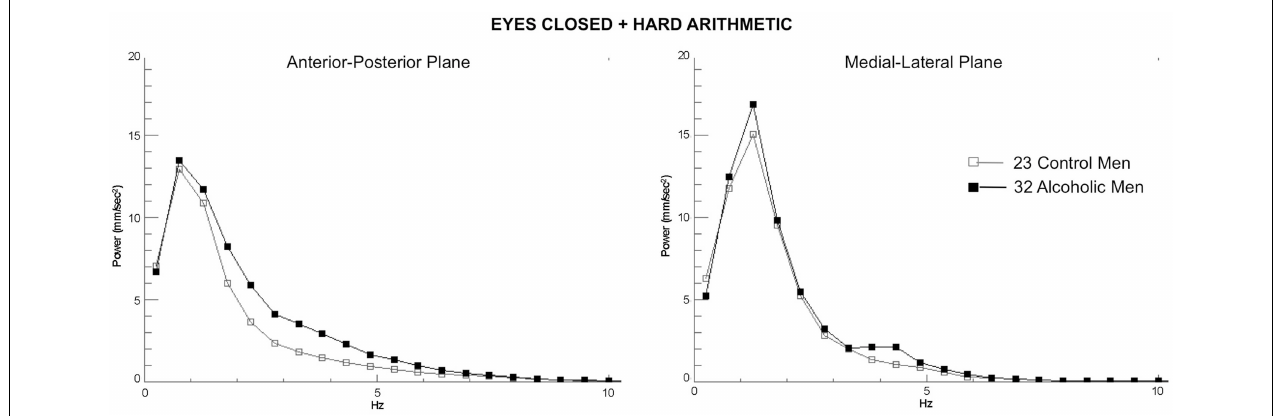
FIGURE 3 | Group average spectra from the frequency analysis of center-of-pressure sway path velocity (distance/time), presented in ∼ 0.5Hz frequency bins for the most difficult test condition (eyes